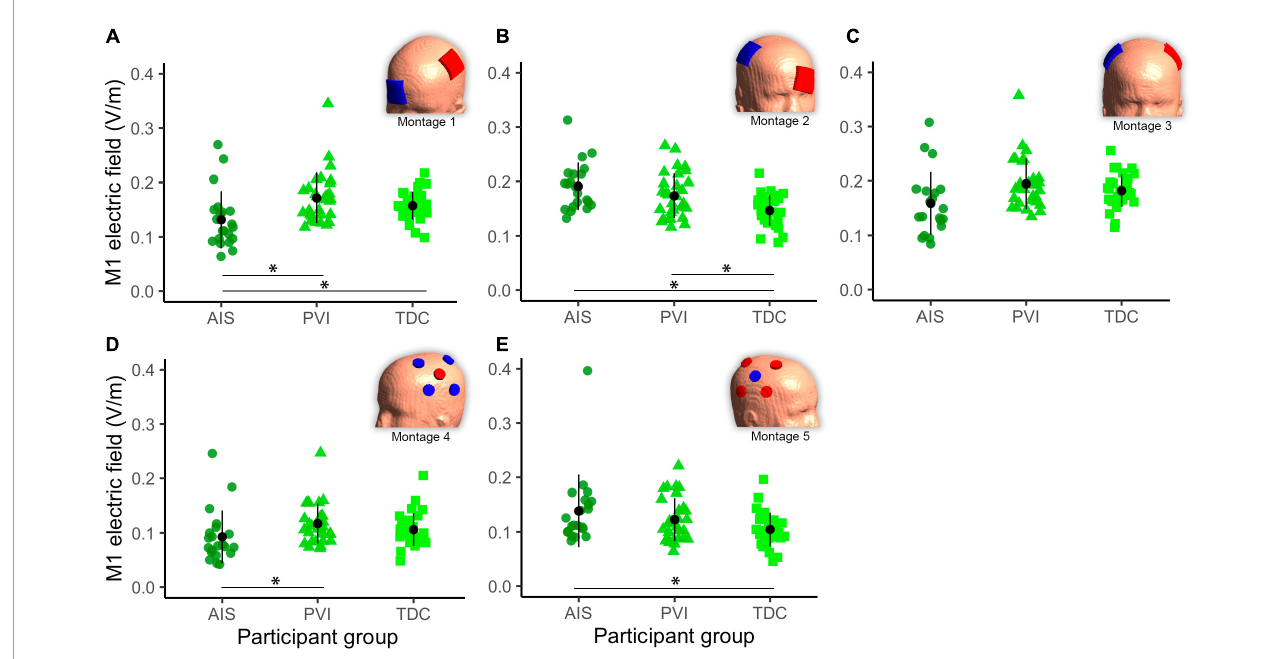
FIGURE5 Mean electric field (EF) in gray matter (GM) of the target primary motor cortex (M1) ROI for five montages by participant group (A–E) . For montages 1, 3, and 4 lesioned M1 was the target, for montages 3 and 5 non-lesioned M1 was the target. Montage diagrams illustrate electrode configuration for a child with a left hemisphere stroke. ROI–region of interest, AIS–arterial ischemic stroke, PVI–periventricular venous infarction, TDC–typically developing control. Horizontal lines denote significant pairwise contrasts (* p FDR < 0.01), vertical lines denote ± 1 standard deviation. Red electrodes denote anode locations, blue electrodes denote cathode